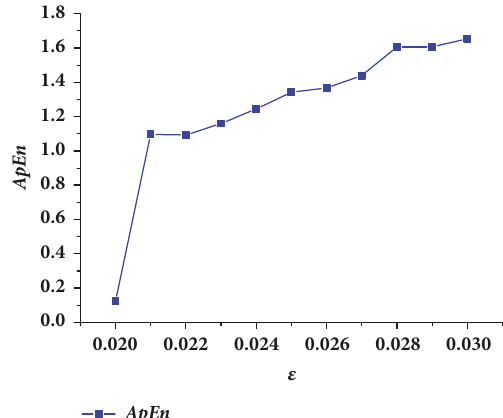
Figure 11: TheApEn of {𝑑𝑈 𝑖 /𝑑𝑡, 𝑖 = 1,2,. .. ,𝑁} based on thesystem (2) for different disturbance parameter 𝜀 . The parameters used here are listed in Table